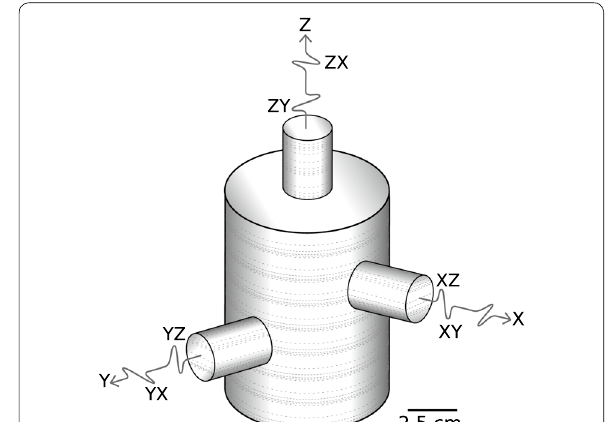
Fig. 3 Orientation of the plugs relative to bedding and to borehole core. The arrows show the propagation direction of the seismic waves. Therefore V p ( X ) , V p ( Y ) and V p ( Z ) correspond to the velocities of compressional waves along X, Y and Z directions, respectively. For shear waves, we used the following convention: the two letters identify the polarization plane while the direction of propagation is indicated by the second letter. For example, V s ( XZ ) is the velocity of a shear wave polarized in the XZ plane and traveling in the Z